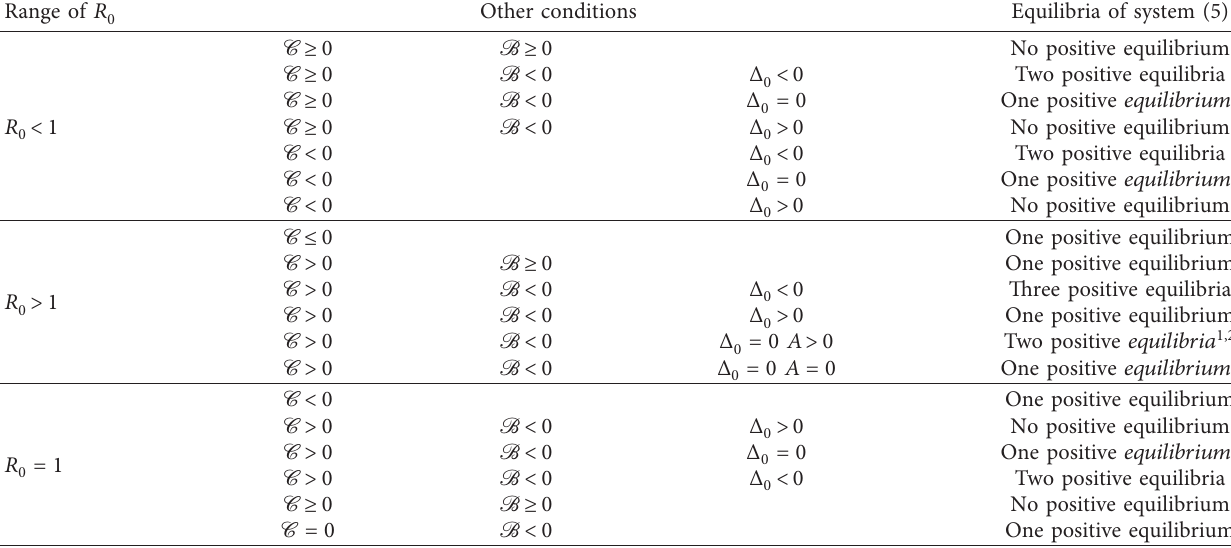
Table. 1: Distribution of the endemic